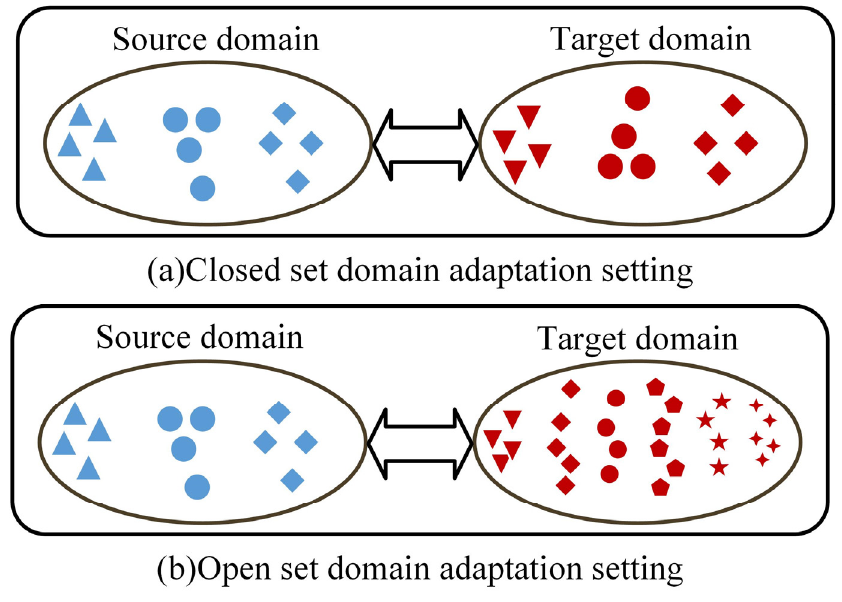
Figure 1. Difference between closed set and open set settings. ( a ) Closed set domain adaptation setting, ( b ) Open set domain adaptation setting